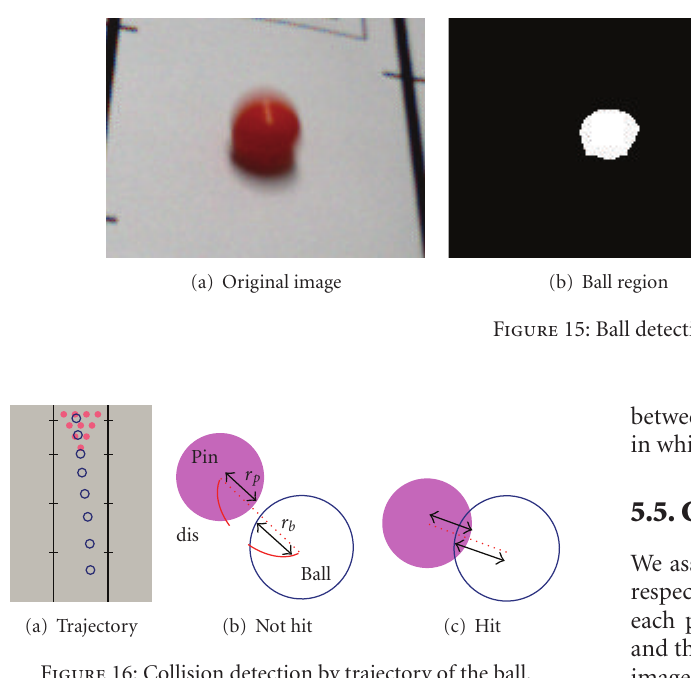
Figure 16: Collision detection by trajectory of the ball.